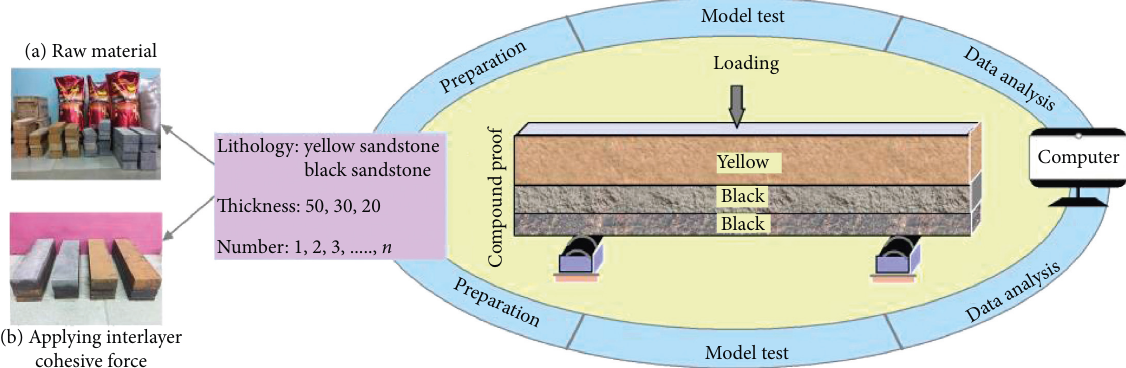
BlackLithology: yellow sandstone